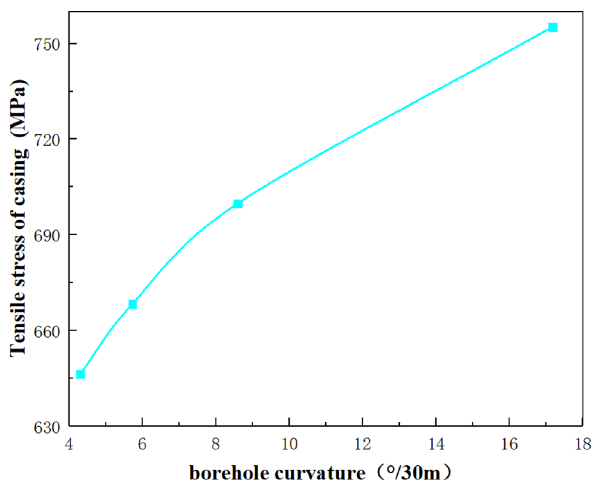
Fig. 6 Coupling curve of casing tensile stress with ground stress field and wellbore